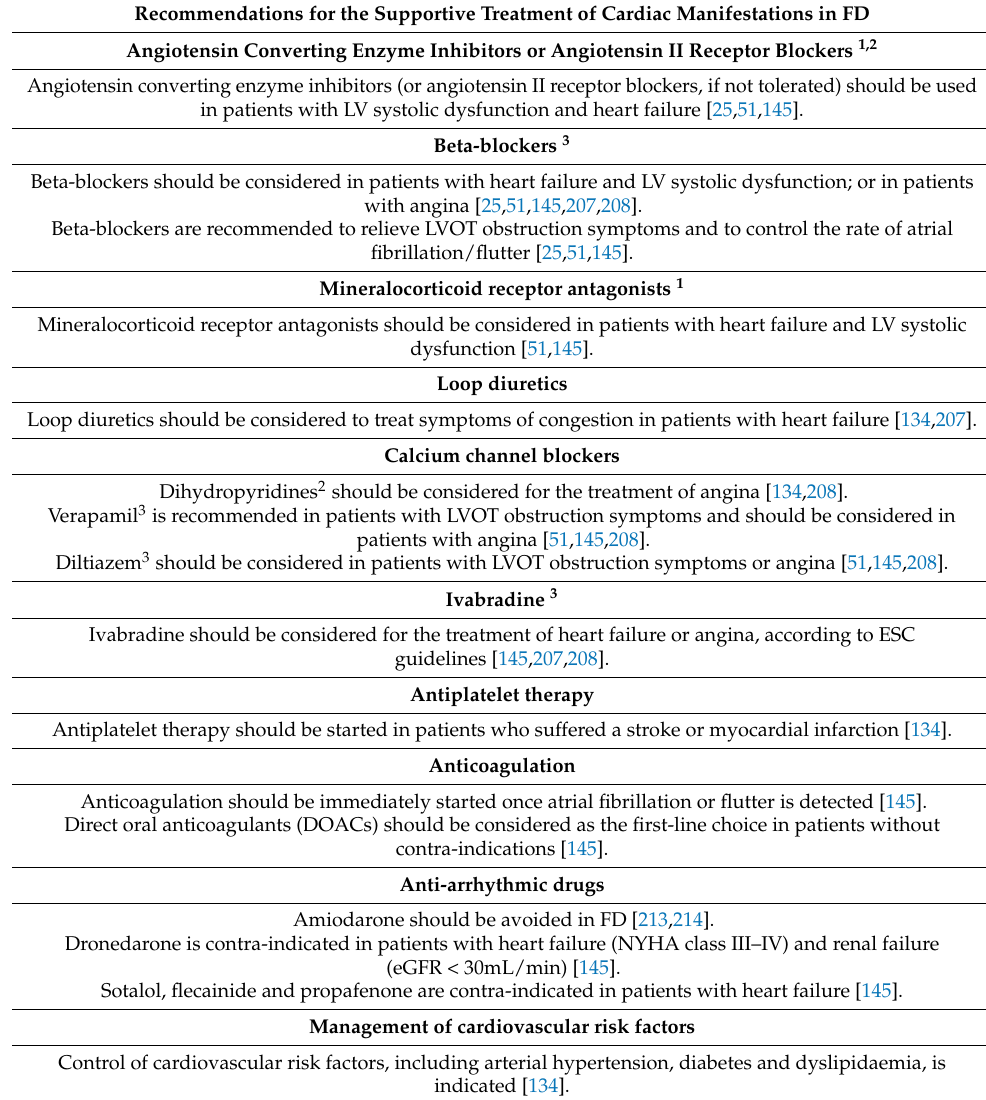
Table 7. Summary of the main recommendations for the supportive treatment of cardiac manifesta- tions in